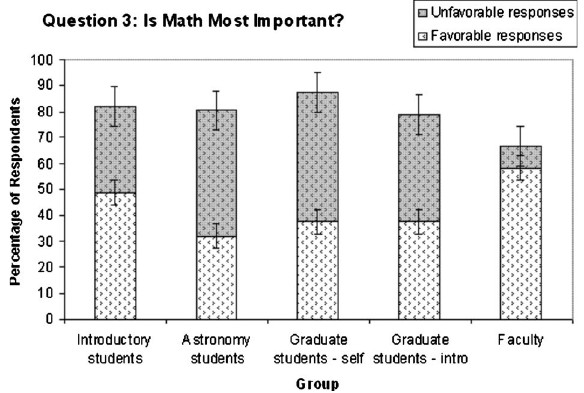
FIG. 10. Histogram showing favorable (cid:1) disagree (cid:2) and unfavor- able (cid:1) agree (cid:2) responses for survey question (cid:1) 3 (cid:2) about whether math- ematics is the most important part of the problem solving process. The histogram shows that a large percentage of nonfaculty respon- dents from all groups agreed with the statement (cid:1) unfavorable (cid:1) ii (cid:2) “Bouncing ideas with someone gives me sort of a